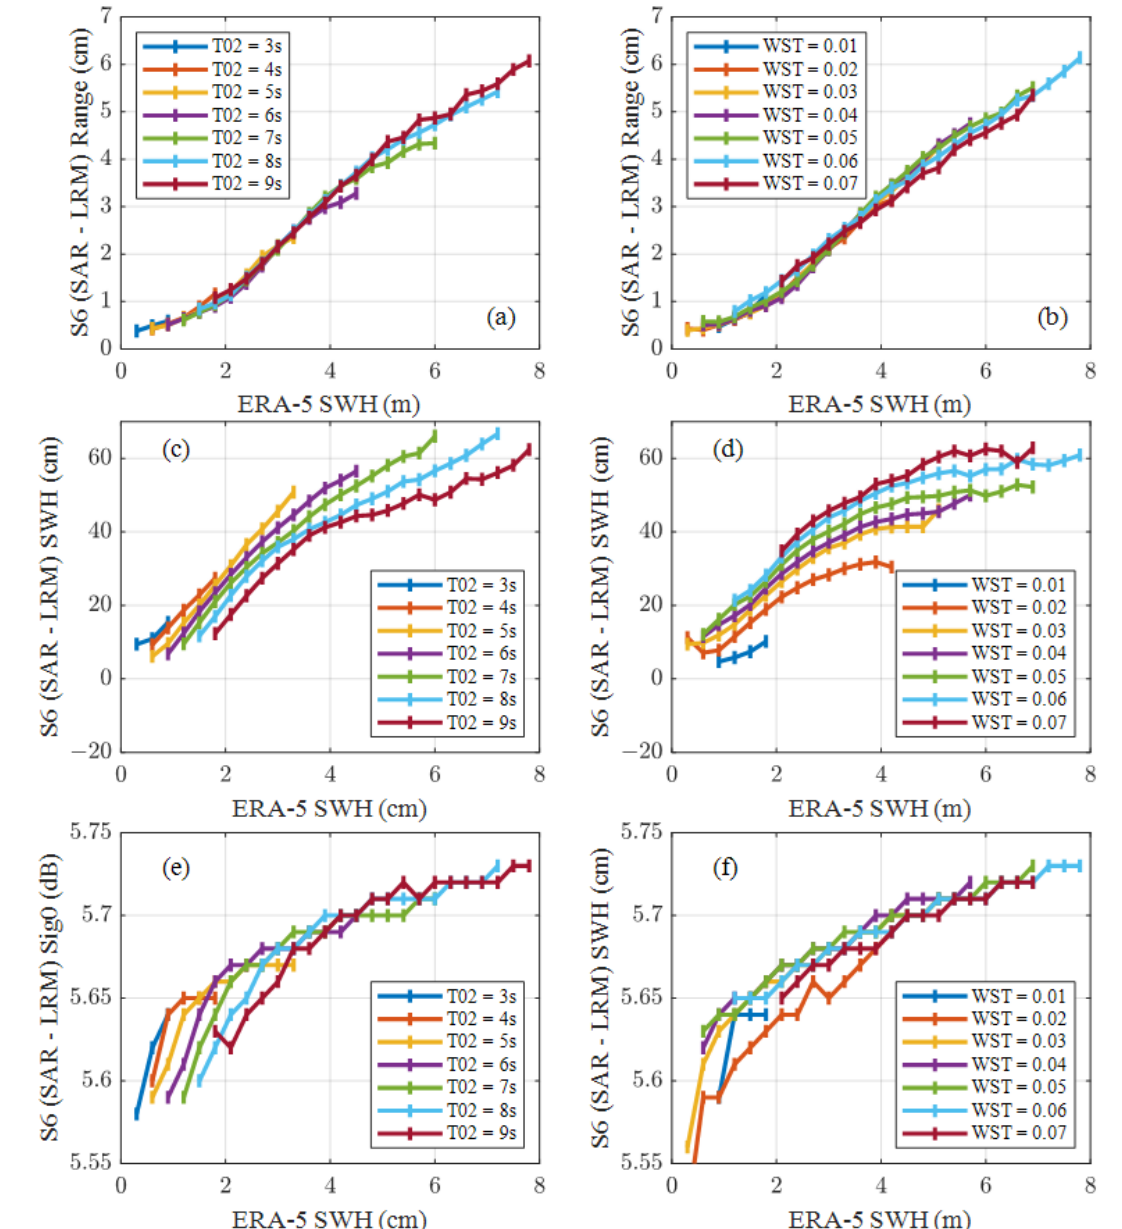
Figure 17. Bin-averaged values of Sentinel-6 (SARM minus LRM) ( a , b ) range, ( c , d ) SWH and ( e , f ) sigma0 against ERA5 SWH estimates for different T02 ( left ) and WST ( right )